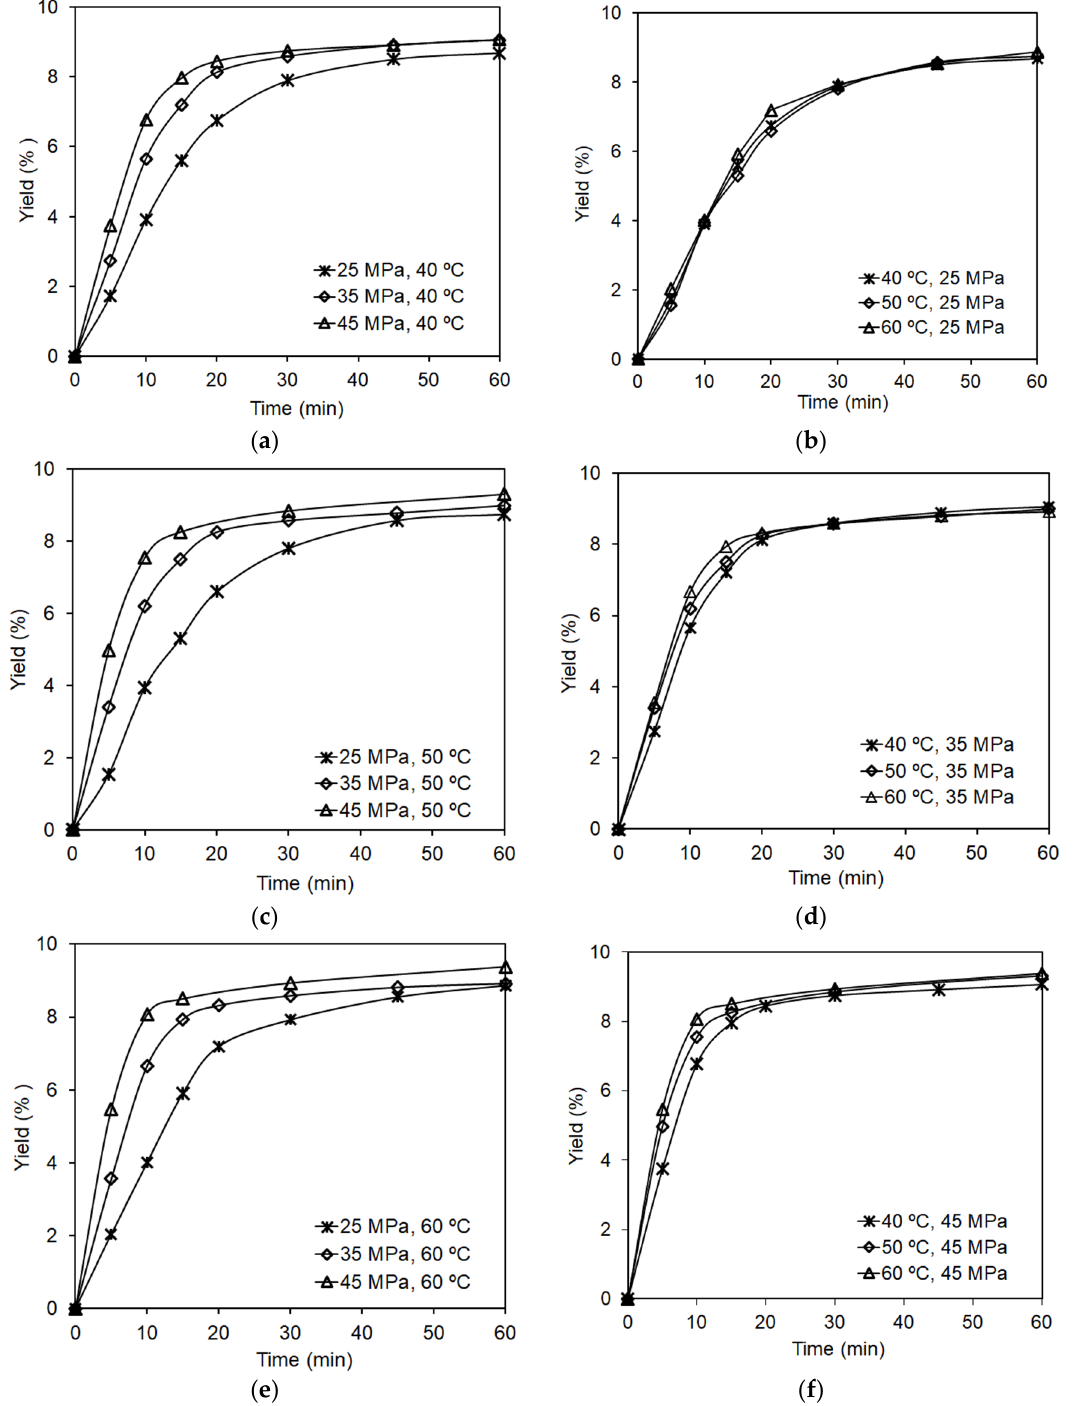
Figure 2. Kinetics of extraction of dry paprika using carbon dioxide depending on pressure and extraction temperature: ( a ) 40 ° C; ( b ) 50 ° C; ( c ) 60 ° C; ( d ) 25 MPa; ( e ) 35 MPa; ( f ) 45 MPa. The analysis of kinetic curves of dry paprika extraction showed that pressure had the highest impact on the extraction rate and yield. The slope of the curves indicates a signif- icant increase in the solubility of paprika extract in carbon dioxide with the increase in pressure at a constant temperature (Figure 2a–c). This could be due to the increase in sol- vent density and its dissolving power. Additionally, higher pressure can destroy the plant cell walls and stronger chemical interactions between different compounds and the struc- ture of the plant cell walls, which can make it easier to extract components from the